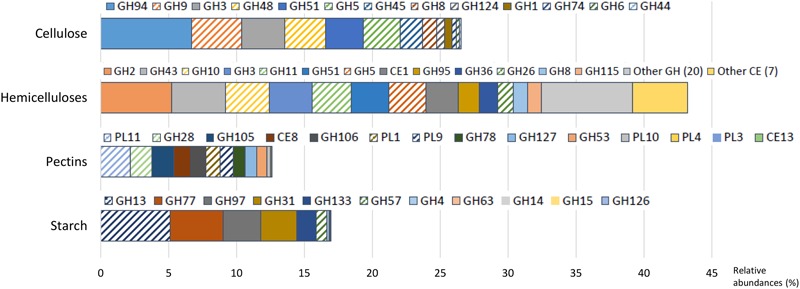
Relative abundances of transcripts encoding carbohydrate-active enzymes (CAZymes) families with known activities involved in the breakdown of cellulose, hemicelluloses, pectins, and starch. Families of endo-acting enzymes which may play a pivotal role in these processes are highlighted by hatches. GH, glycoside hydrolase; CE, carbohydrate esterase; PL, polysaccharide lyases.